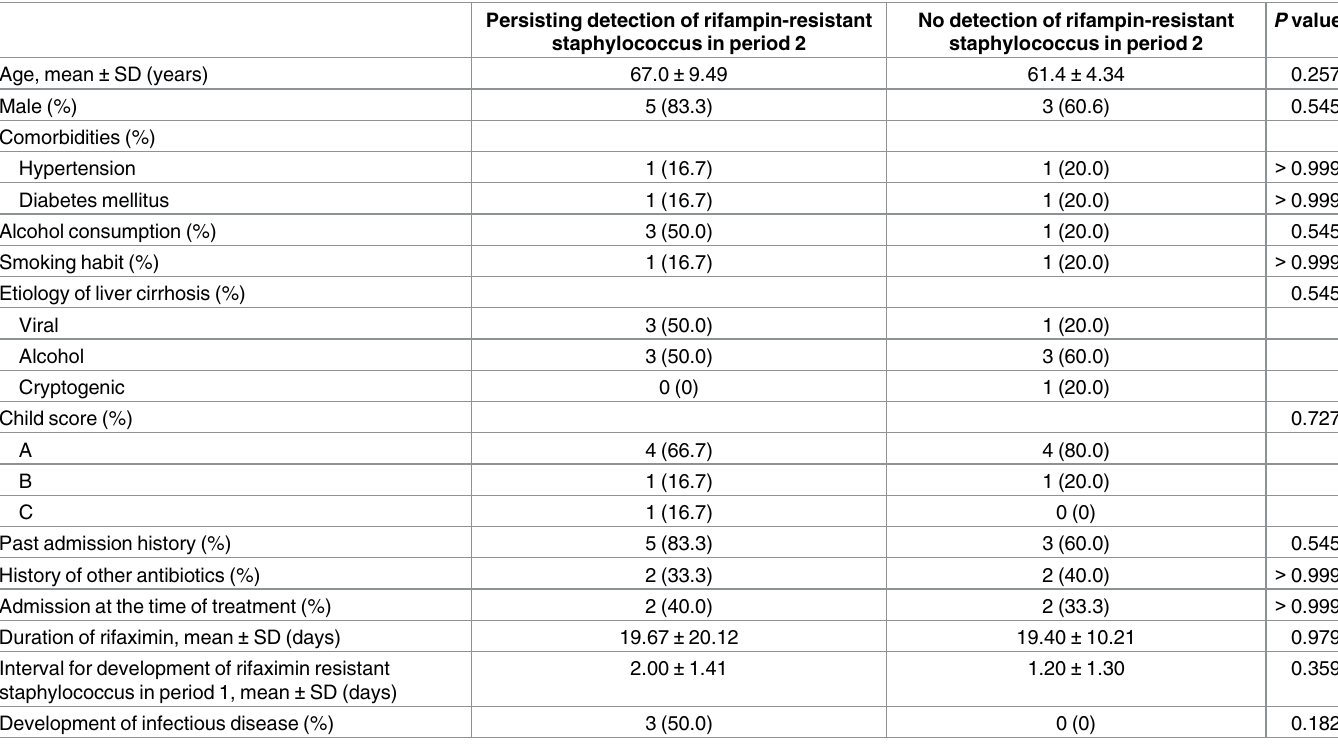
Table 4. Predictive factors for persisting detection of rifampin-resistant staphylococcus in period 2 among the patients with rifampin-resistant staphylococcus in period